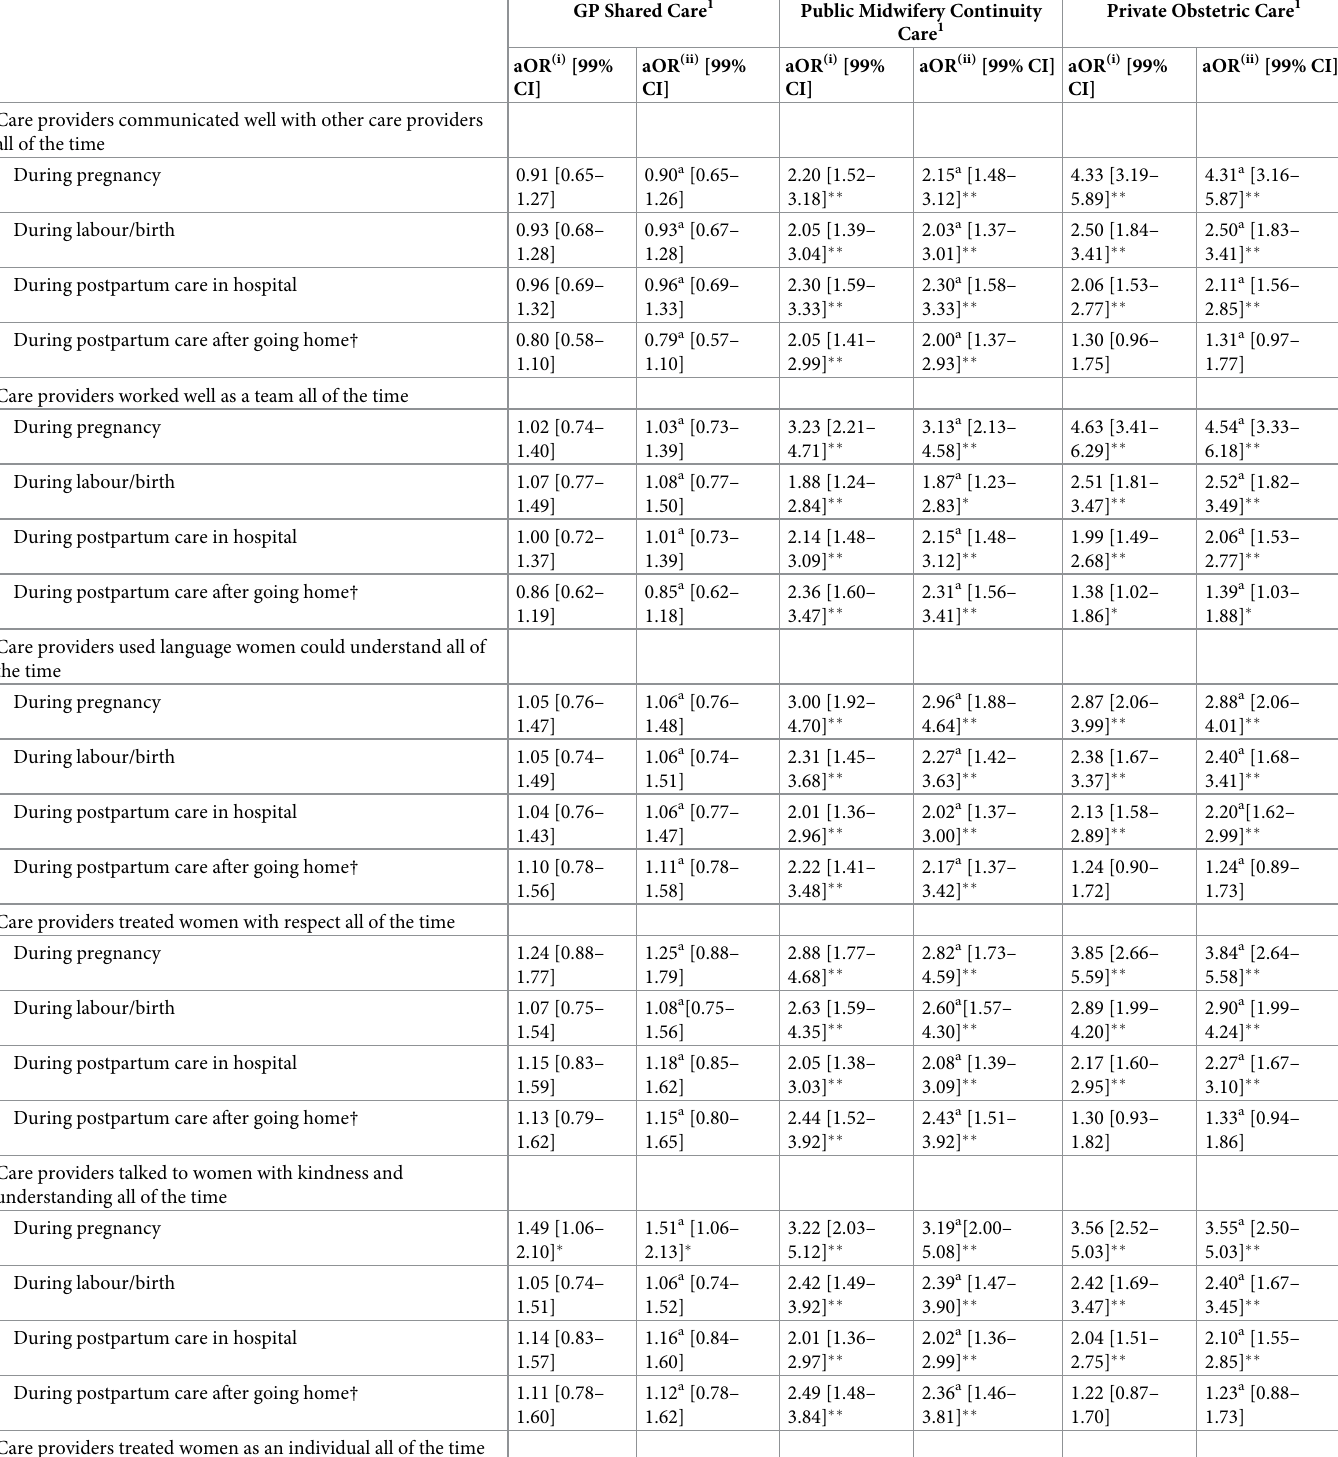
Table 7. Adjusted odds ratios for maternal experiences of interpersonal quality of care by maternity model of care, adjusting for (i) sociodemographic characteris- tics, reproductive history, and (ii) with additional adjustment for relevant clinical